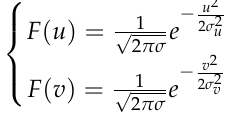
Figure 5. Region of Interest (ROI) pooling module and detection head.